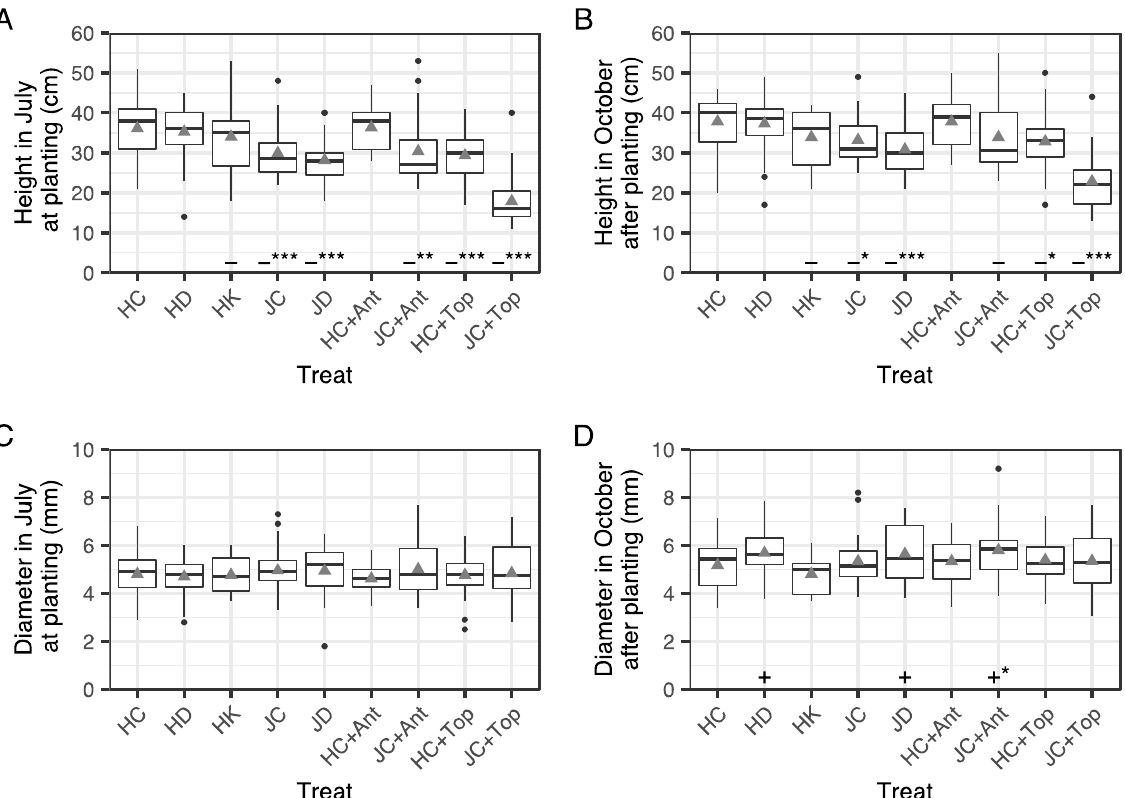
Figure 4. Boxplots with mean values (gray triangles, n = 17–30) of height and root collar diameters of surviving container seedlings of Japanese larch grown in Hiko-V-120 (H) and JFA-150 (J) containers with control irrigation and fertilization (HC and JC), dry irrigation (HD and JD), high-potassium fertilization (HK), application of antitranspirant (+Ant), and topping (+Top) measured at planting ( A , C ) and three months after planting ( B , D ). The dots indicate outliers. The plus or minus sign indicates a positive or a negative effect, respectively, compared with the HC treatment in the generalized linear mixed model. * p < 0.05, ** p < 0.01, *** p < 0.001.